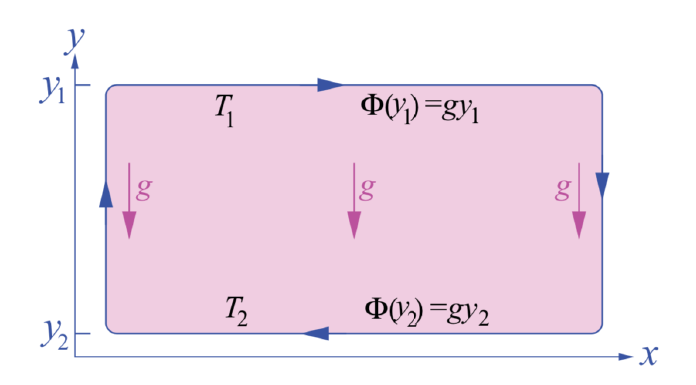
< T and lower one at T ( T ). The chiral 1 2 1 2